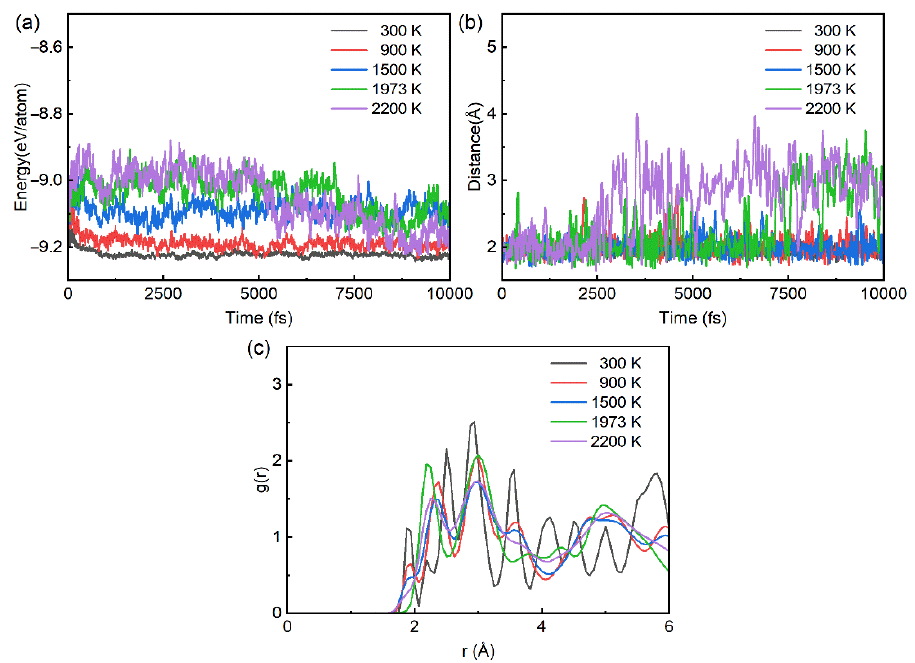
Figure 3. The ( a ) average energy per atom, ( b ) C − Si distance, and ( c ) radial distribution function variation during the Ab initio molecular dynamics (AIMD) simulation of U 3 Si 2 C 2 at 300 K, 900 K, 1500 K, 1973 K, and 2200 K.